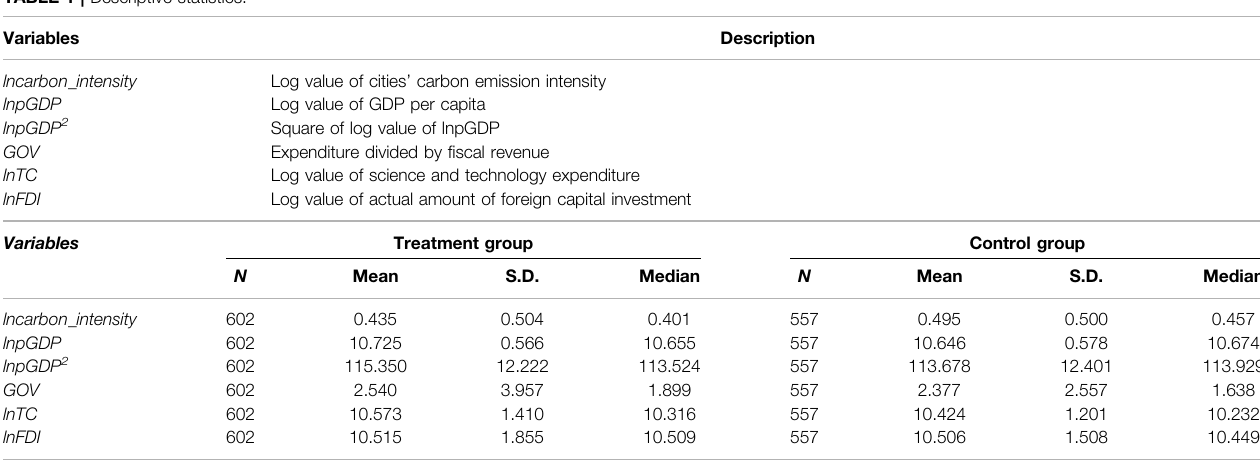
TABLE 1 | Descriptive statistics.